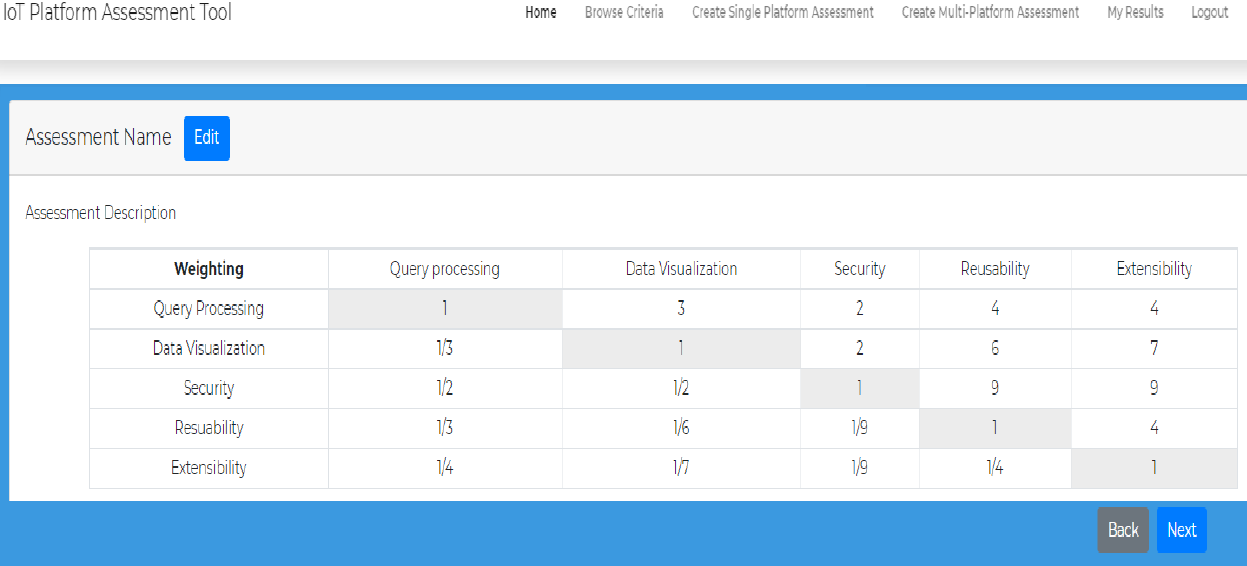
Figure 6. Pairwise comparison of the selected criteria.